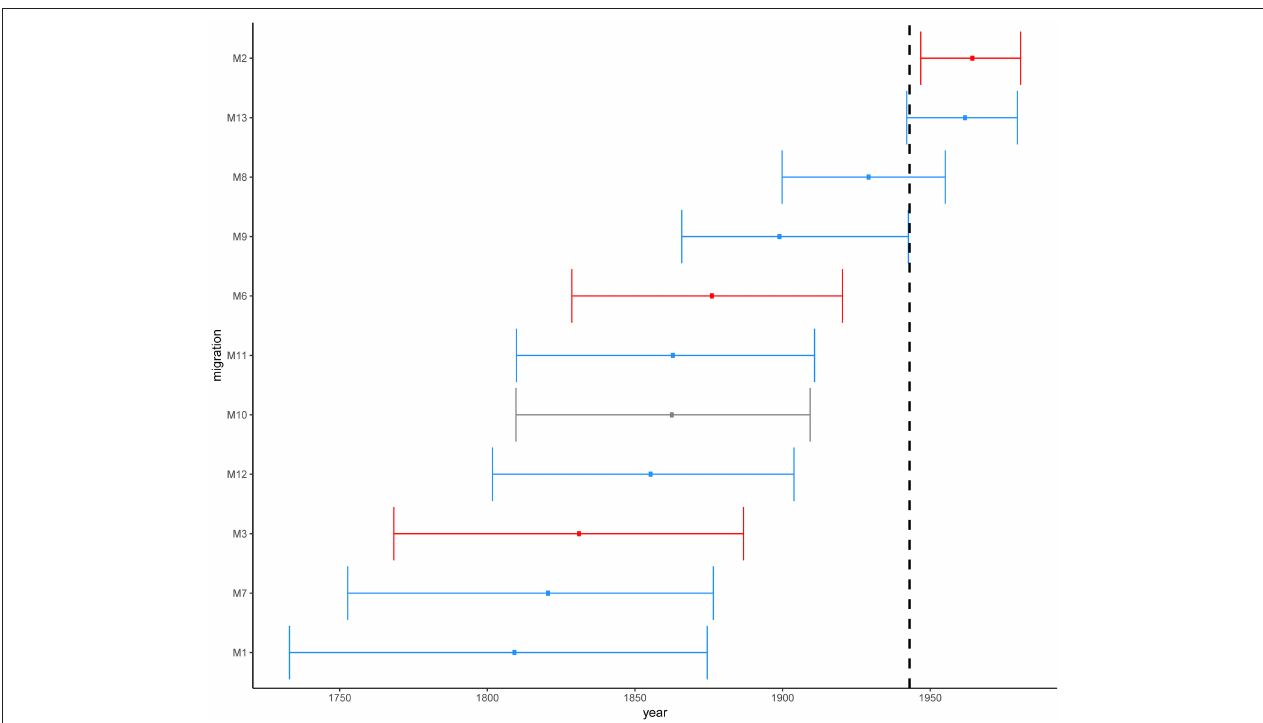
FIGURE 5 | Estimated time in median ages for the introductions of African L2–Beijing (M1-M3 and M6-M13). Introductions to Eastern Africa are colored in red and those to Southern Africa in blue. Migration M10 contained L2–Beijing from both Southern and Eastern Africa. Dotted line marks the year of first anti-TB drug discovery (1943). The error bars correspond to the 95%